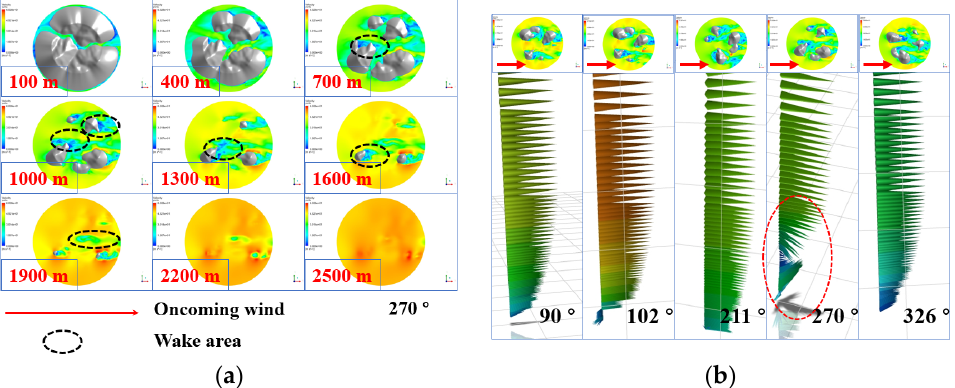
Figure 10. Profile and speed contour: ( a ) Wind speed profile of different oncoming directions; ( b ) Wind speed contour at different heights.